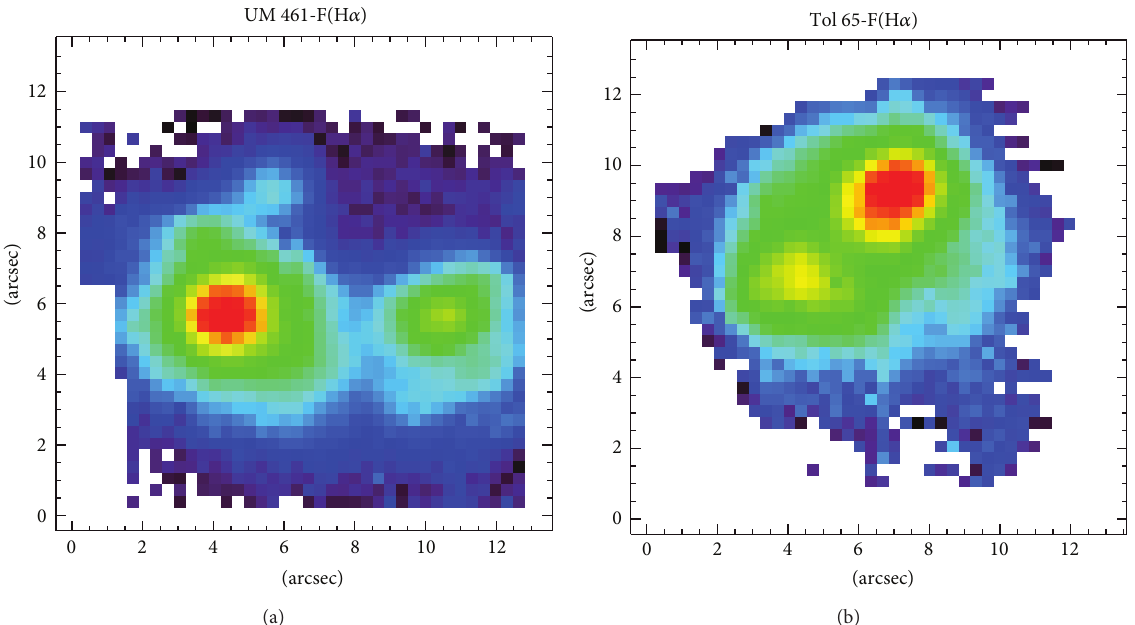
Figure 3: VIMOS-IFU H 𝛼 emission line map of the XMP BCD galaxies UM 461 (a) and Tol 65 (b). North is to the top and east to the left. Further details will be presented in a forthcoming paper.